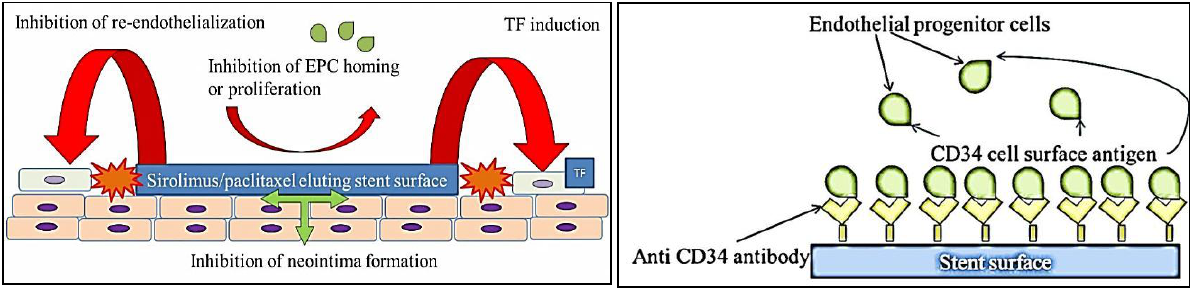
Coronary stent types, their mechanism of action and innovations: ( a ) first generation drug eluting stents (DES) impact on vascular biology: Modified from [42], reduced neointima formation (green arrows) but increased thrombogenicity at stent bio-interface. Sirolimus/paclitaxel inhibition of endothelialization, tissue factor induction and